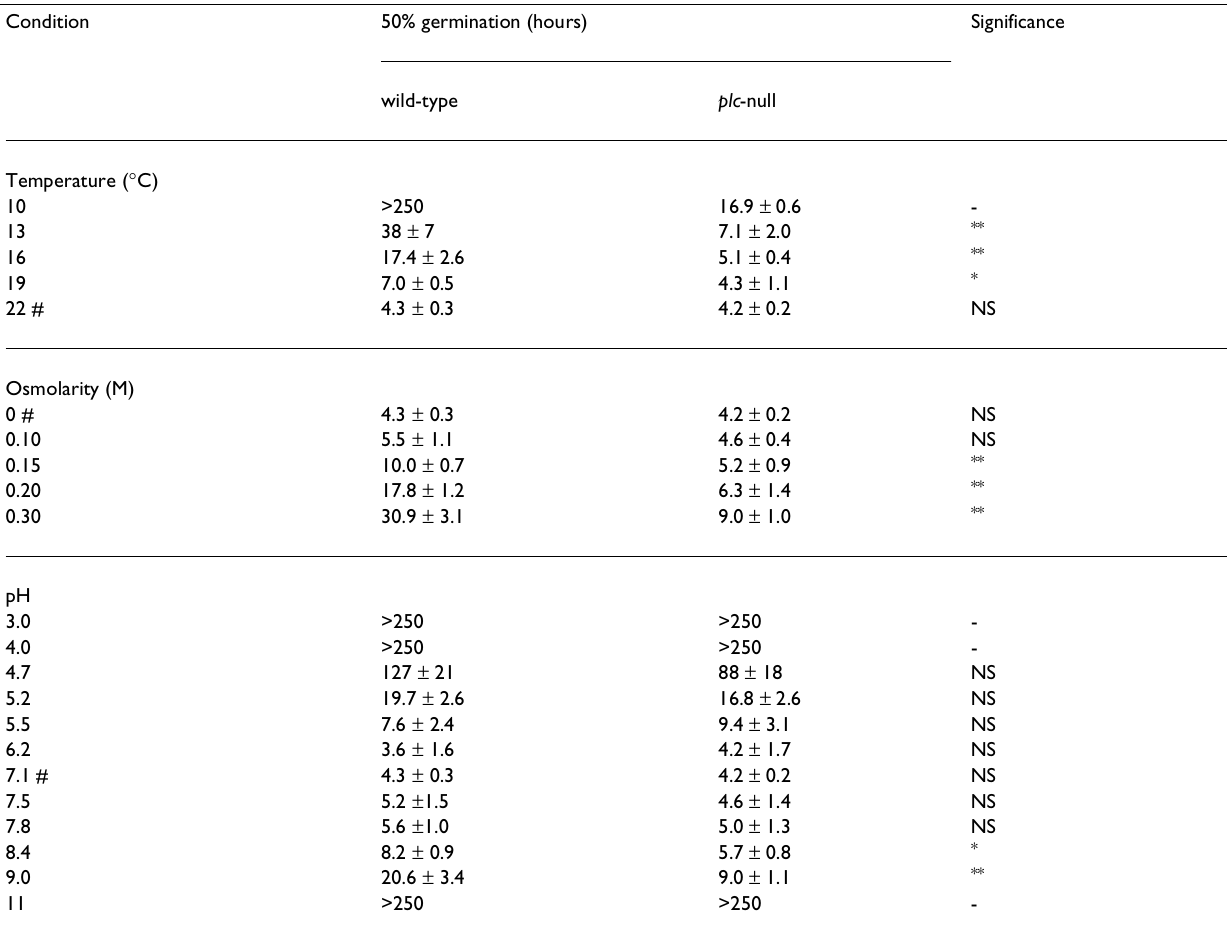
Table 1: Spore germination at different environmental conditions Condition 50% germination (hours)